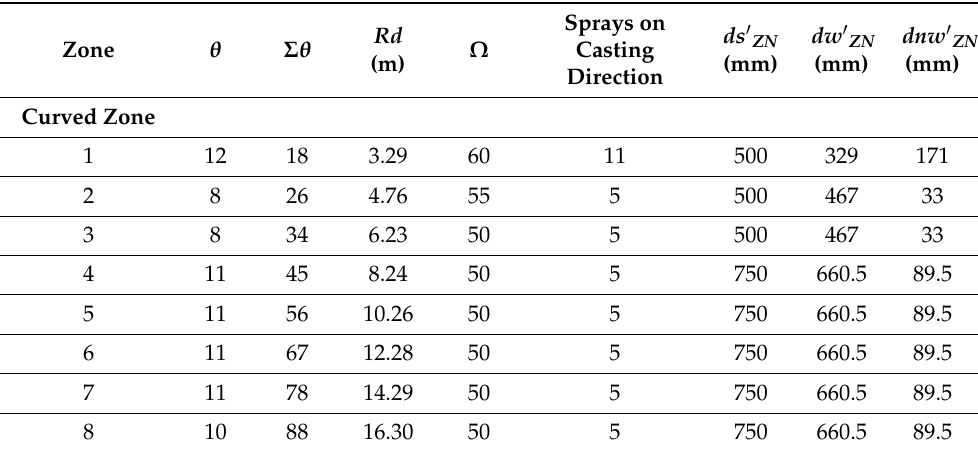
Table 7. Dimensions of the SCS in the curve zone (for